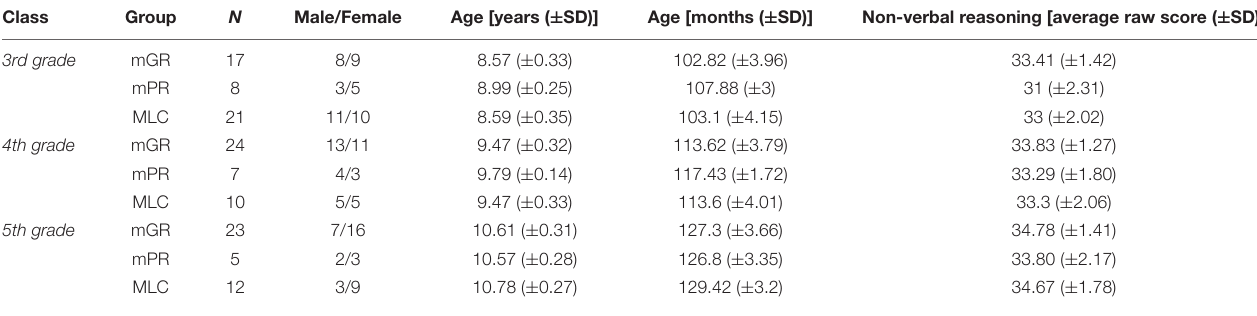
TABLE 1 | Participants’ demographic